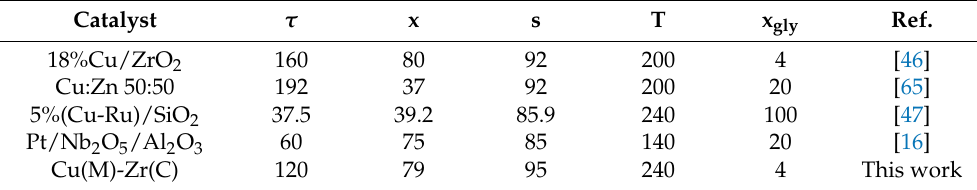
Table 3. Catalytic performance of different catalysts proposed for glycerol hydrogenolysis